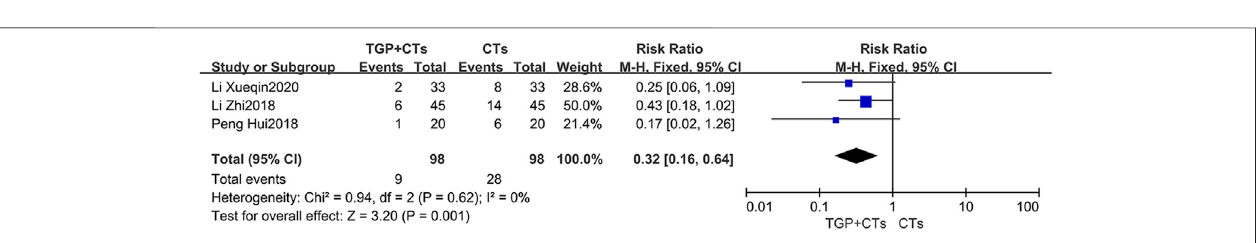
FIGURE 10 | Forest plot of disease recurrence